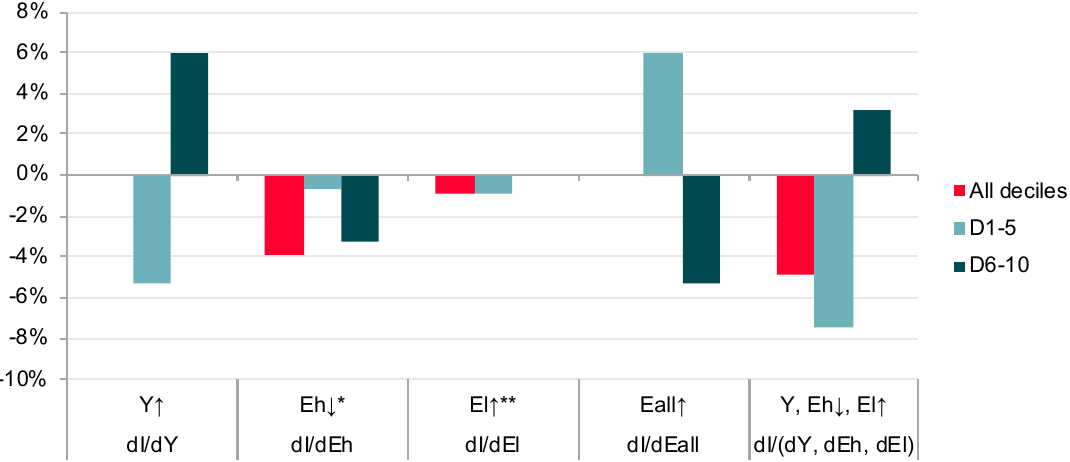
Figure 2. Results of sensitivity scenarios for HS (10% change of indicator components). * high energy expenditure defined as above twice the national median expenditure. ** under-consumption defined as below half the national median expenditure. Arrows denote an ↑ increase and ↓ decrease.